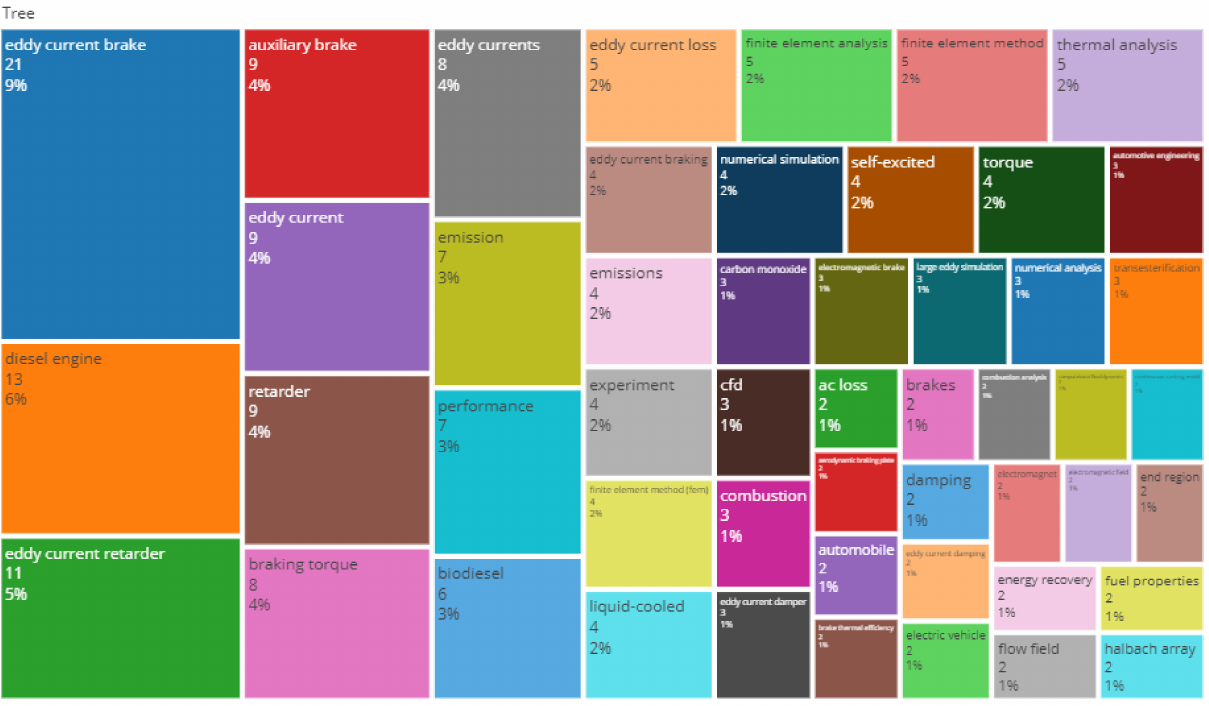
Figure 10. Treemap analysis (Field: Author’s Keywords).